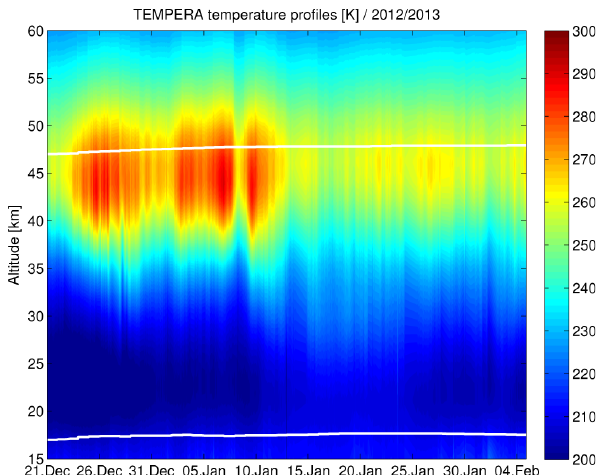
Fig. 21. Retrieved temperature profiles from 15 to 60km from 21 December 2012 to 4 February 2013 (46 days). The white lines indicate the region where